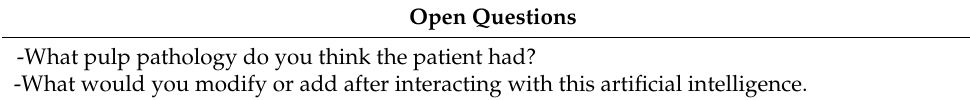
Table 4. Free text response